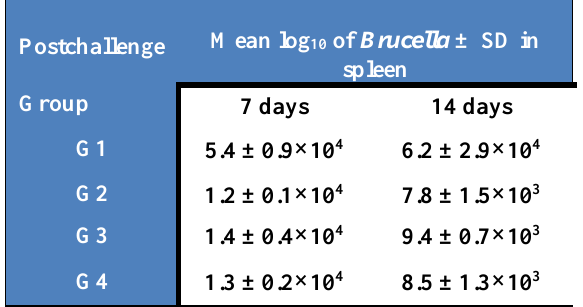
Table, 3: The protective efficacy against B. abortus virulent strain that conferred by immunization with SEBA with β-glucan or non β-glucan compared to B.abortus S19 or non-vaccinated group at 7 and 14 days